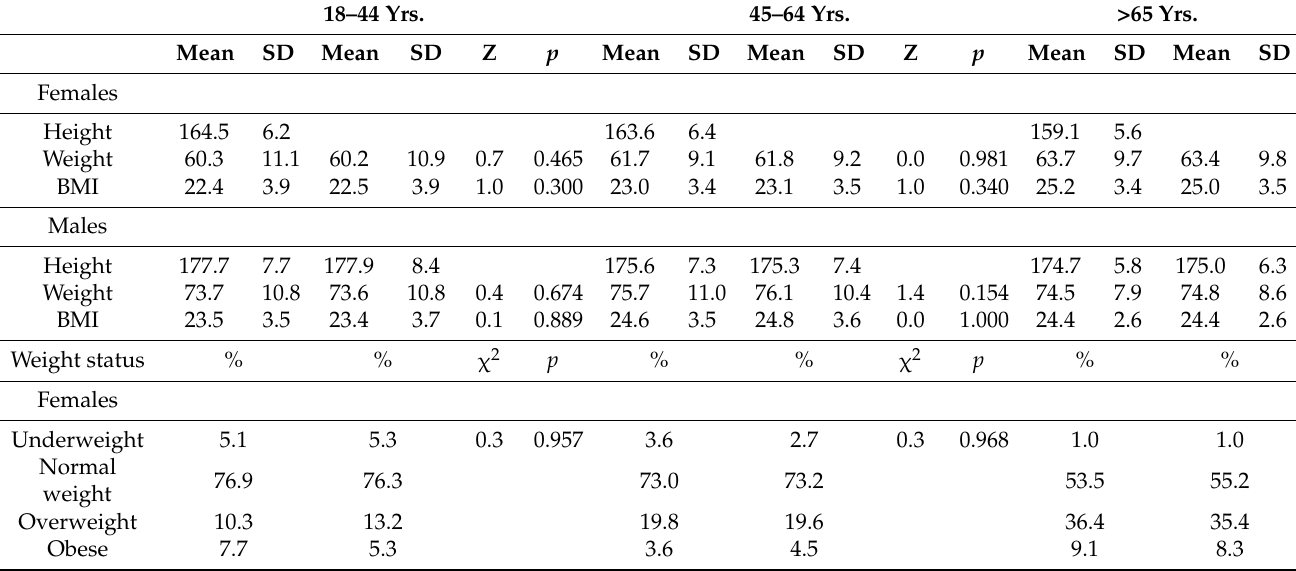
Table 3. Anthropometric parameters and weight status of the